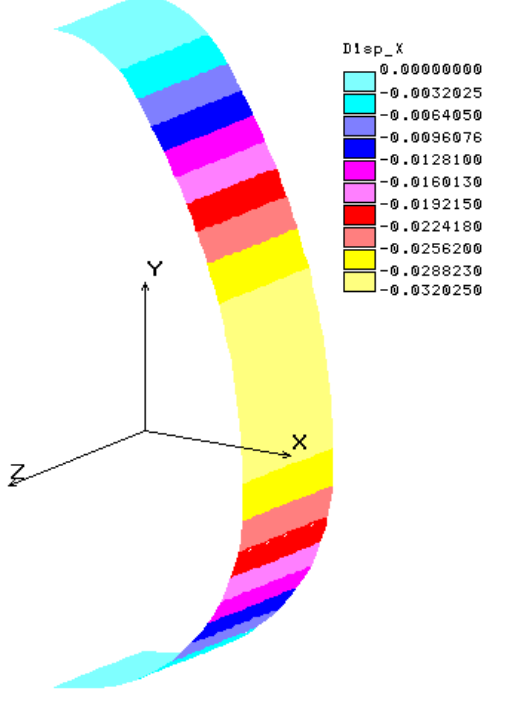
Figure 4: Horizontal displacements (load scheme 1 – wall thickness equal to 19 mm).